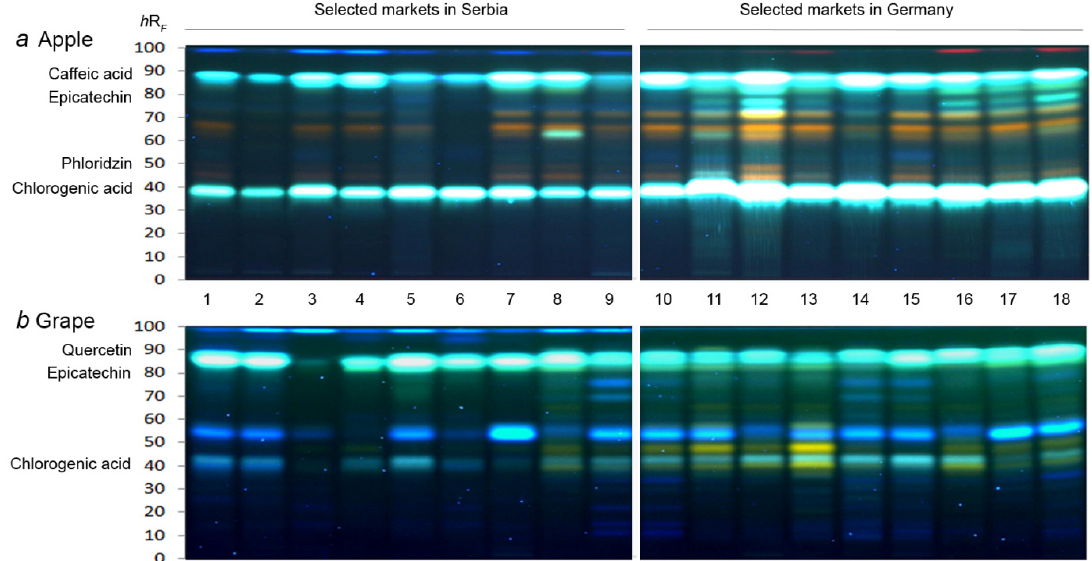
Figure 1. HPTLC − FLD profiles at 366 nm after derivatization with natural product A reagent of extracts of ( a ) apple and ( b ) grape juices from selected markets in Serbia (1 − 9) and Germany (10 − 18).